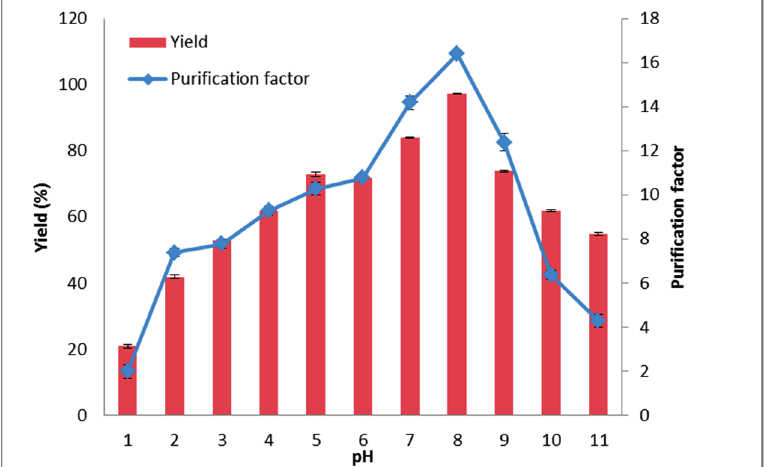
Figure 4. Influence of pH on partitioning of the lipase in Triton X-100/xylitol ATPS. Effect